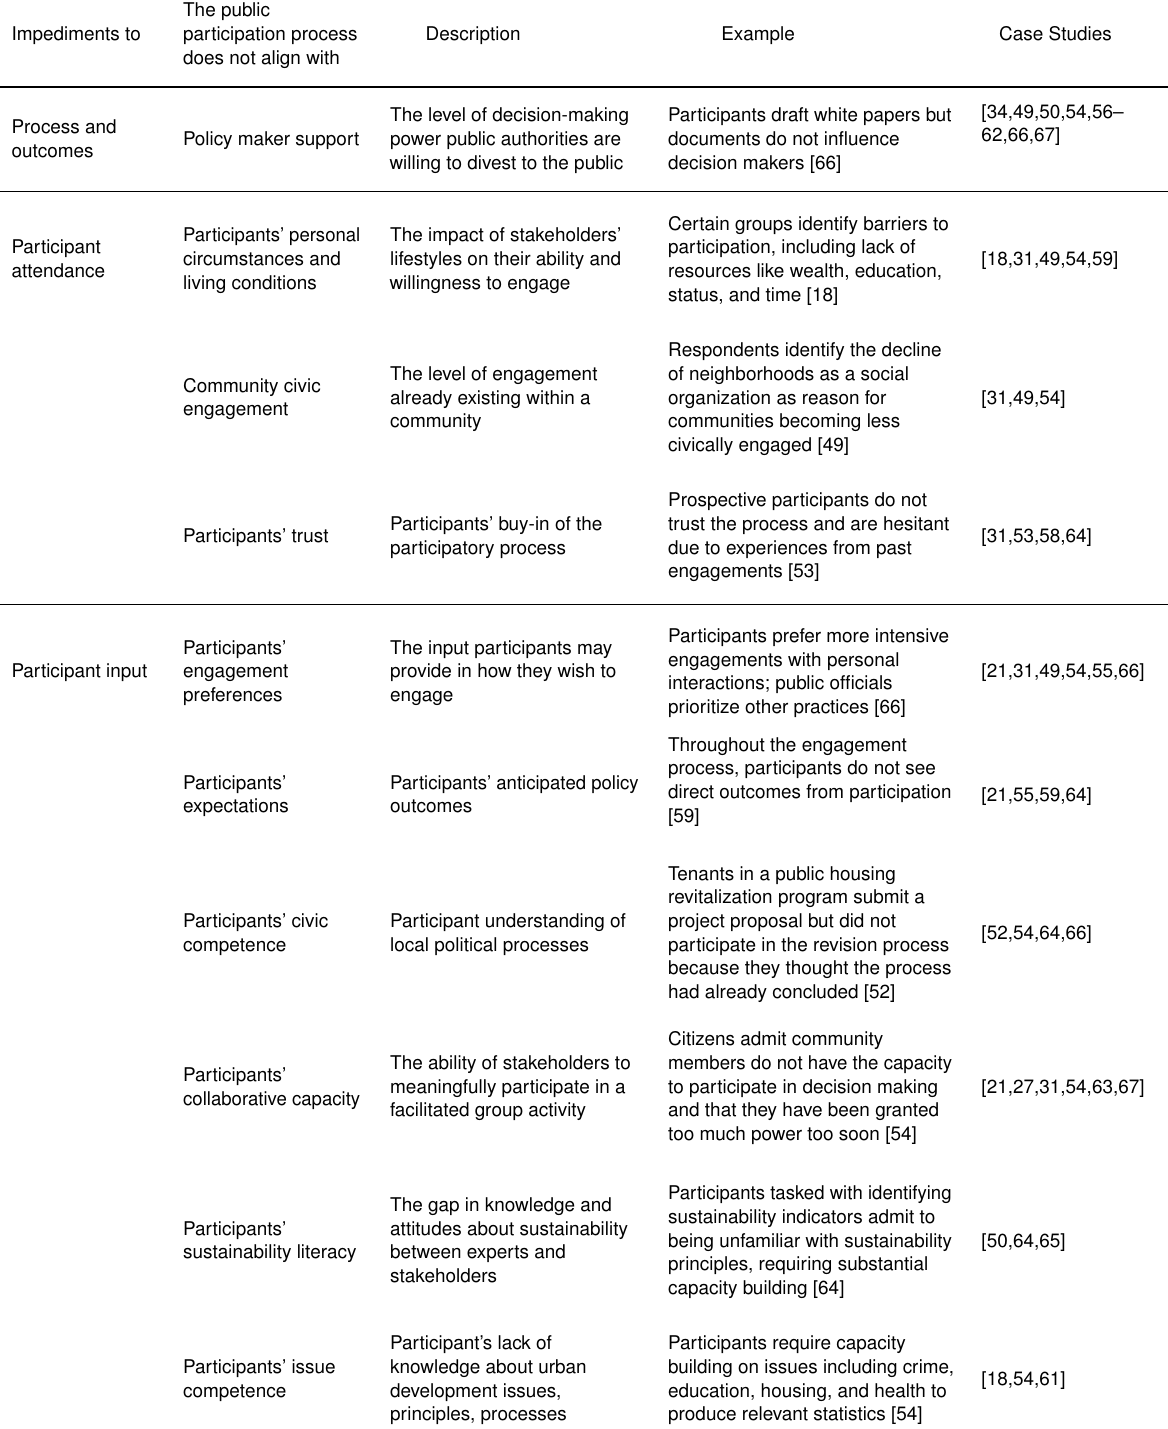
Table 2. Misalignments between public participation process and local